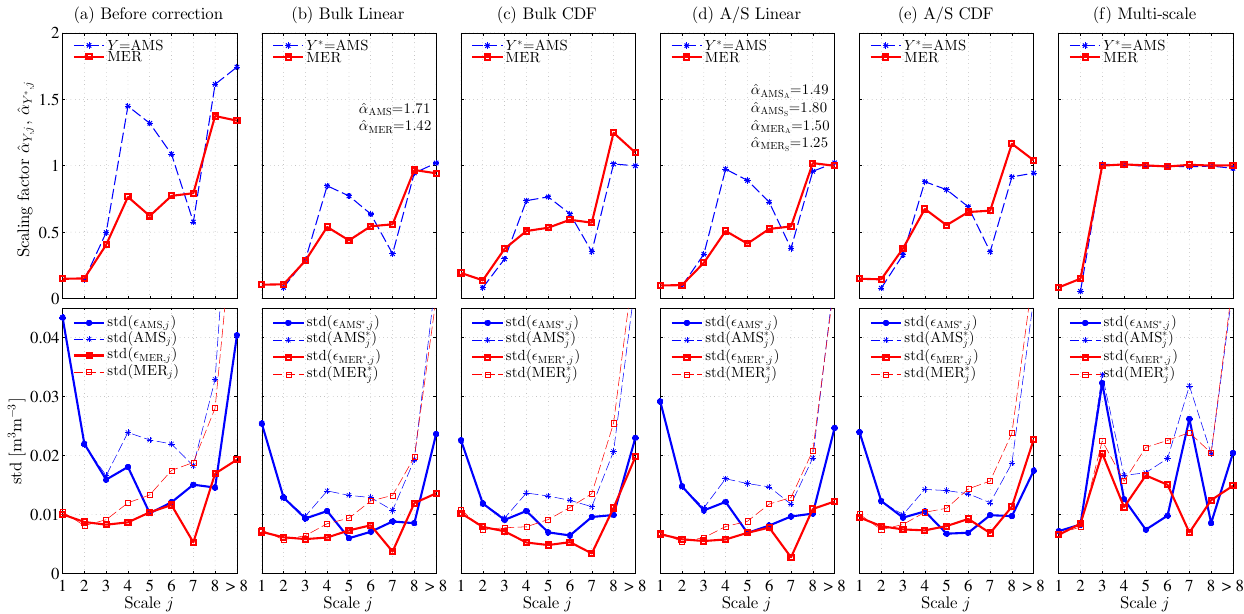
Figure 5. Bias correction of AMS and MER (as Y ) with respect to INS (as X ), showing the impact of 5 correction schemes on the scaling coefficients, noise and total SD on individual scales. Estimated ˆ α Y,j (cid:54)= 1 or ˆ α Y ∗ ,j (cid:54)= 1 suggests multiplicative bias in Y j or Y ∗ as per Eq. (6). j (a) is the diagnosis of Y before correction, and (b–f) are that of Y ∗ after correction. The estimated ˆ α Y,j and ˆ α Y ∗ ,j for the diagnoses are derived using OLS (for j = 1, 2) and TC ( j > 2). The additional ˆ α Y values listed in (b, d) are the scaling coefficients used in the implementations of bulk and A/S linear rescaling. Scale j > 8 corresponds to Y ( a ) . 8